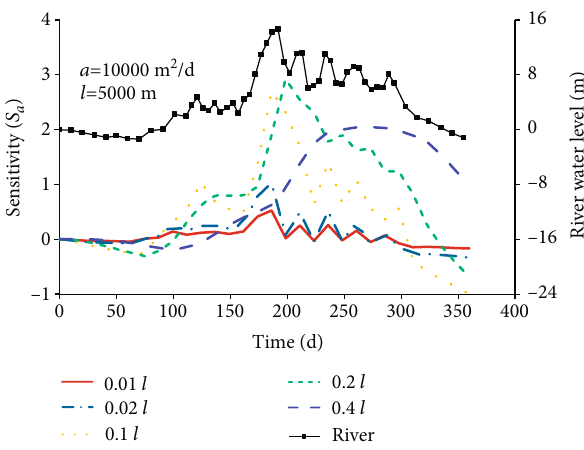
Figure 9: Normalized sensitivity of hydraulic head u to hydraulic di ff usivity a versus